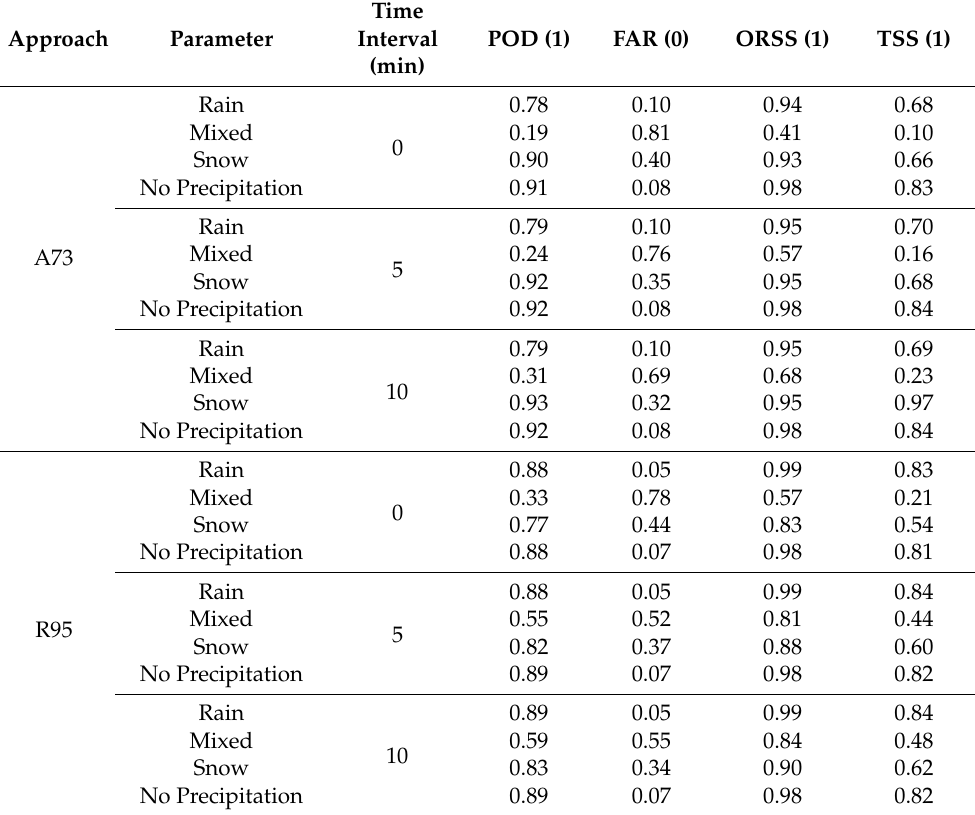
Table 6. Verification scores of Method2 precipitation type at the lowest height bin compared with disdrometer observations. Time interval windows of 0, 5 and 10 min were considered for both A73 and R95 precipitation type approaches. Perfect values for each verification score are given in